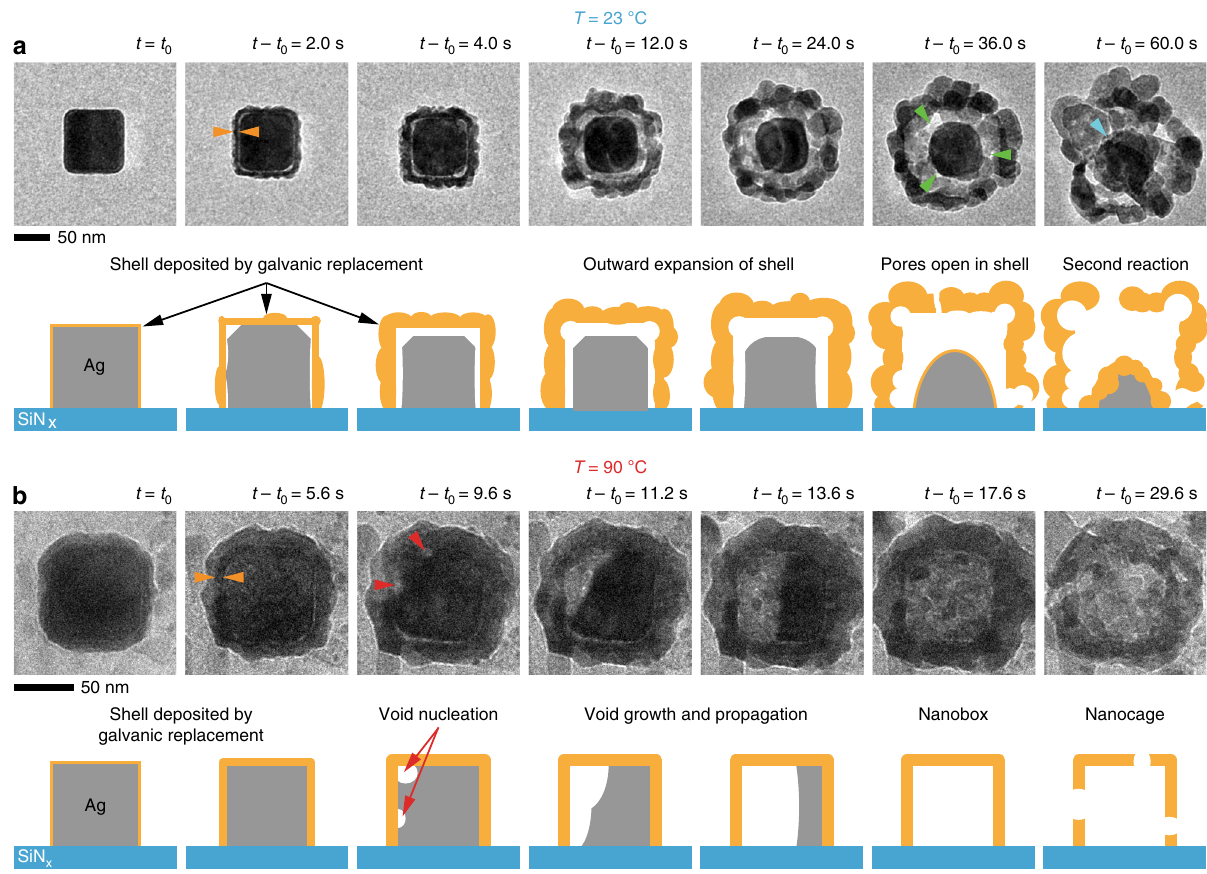
Fig. 1 Galvanic replacement of Ag nanocubes by Au at 23 and 90 °C. a Time series of in situ transmission electron microscopy (TEM) images (Supplementary Movie 1) and corresponding schematics showing the morphological evolution of an Ag nanocube during galvanic replacement (GR) reaction at 23 °C. Green arrows indicate pores that form in the deposited shell, and a cyan arrow points to a second GR reaction on the residual Ag core (formation of a rough shell) after it is again exposed to the Au solution through pores on the outer shell. b Time series of in situ TEM images (Supplementary Movie 2) and schematics showing the morphological evolution of an Ag nanocube during GR at 90 °C. Orange arrows indicate the inner shell with darker contrast, which should be the Au layer. Red arrows indicate observed void nucleation. Here, t 0 indicates the start of